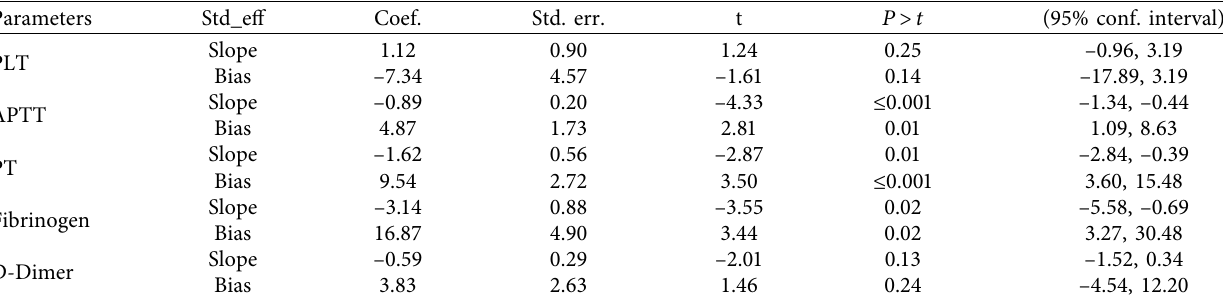
Table 2: Egger’s